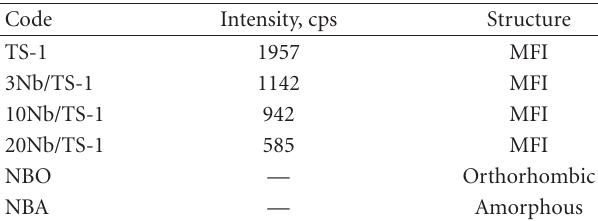
Table 2: Structure and crystallinity of samples.